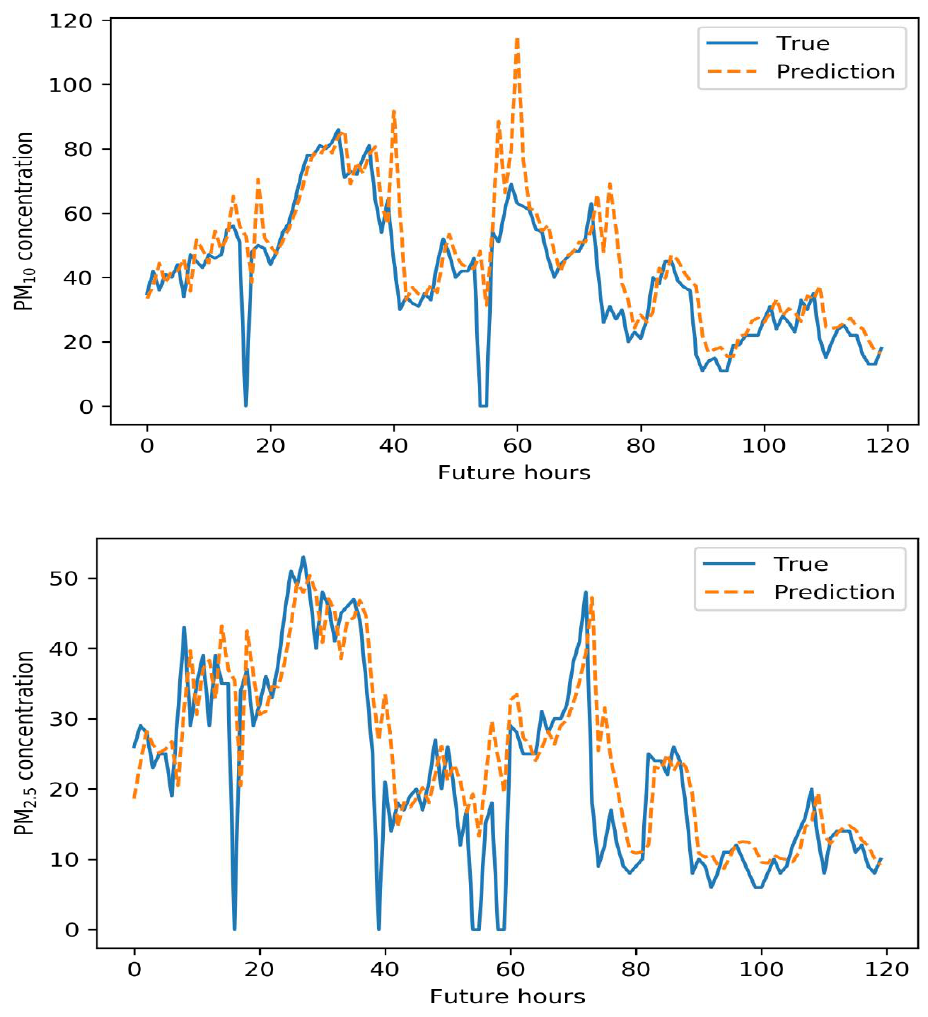
Figure 8. Five-day air pollution levels predicted by the GRU model. Atmosphere 2020 , 11 , x FOR PEER REVIEW